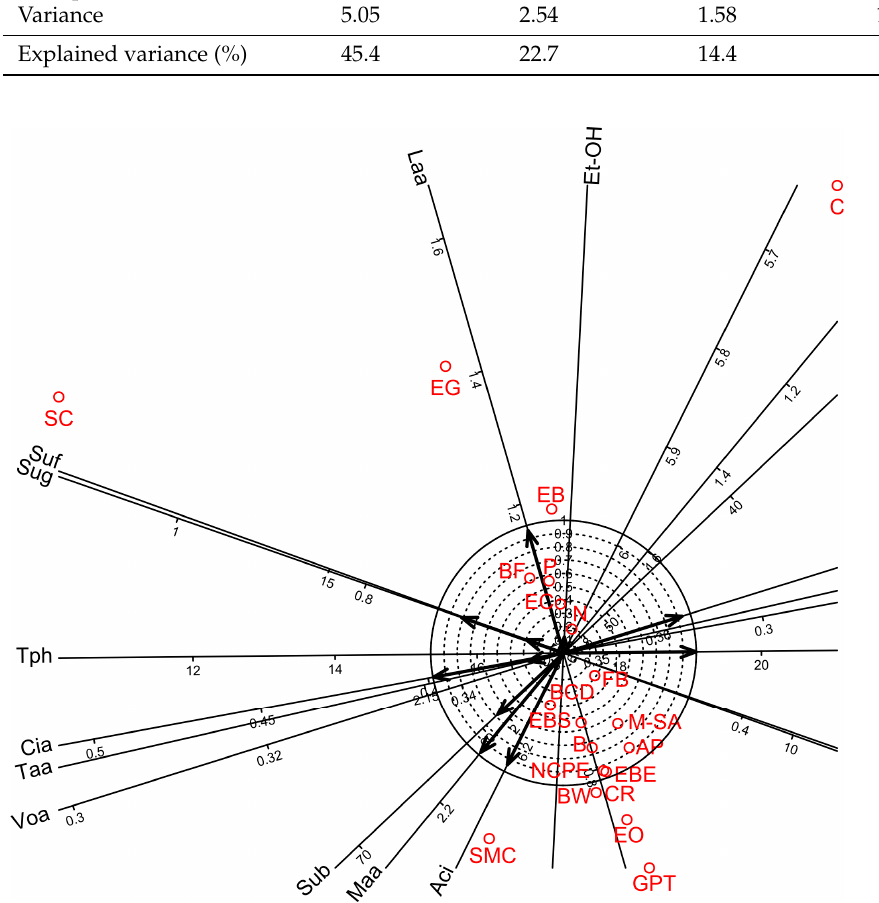
Figure 1. Biplot diagrams of Factor 1 versus Factor 2 of Principal Axis Factor Analysis (Iterated Principal Factor) conducted for ten oenological measurements of white wine samples in twenty-one bentonite product treatments (Debrecen-Pallag, Hungary). Oenological parameters are Et-OH: Ethyl-alcohol, Sug: Sugar, Aci: Acidity, Taa: Tartaric acid, Maa: Malic acid, Laa: Lactic acid, Cia: Citric acid, Voa: Volatile acid, Suf: Sulphur-free, Sub: Sulphur-bound, Tph: Total phenol. Explanations for bentonite product name abbreviations (red colour) are given in Table 1.